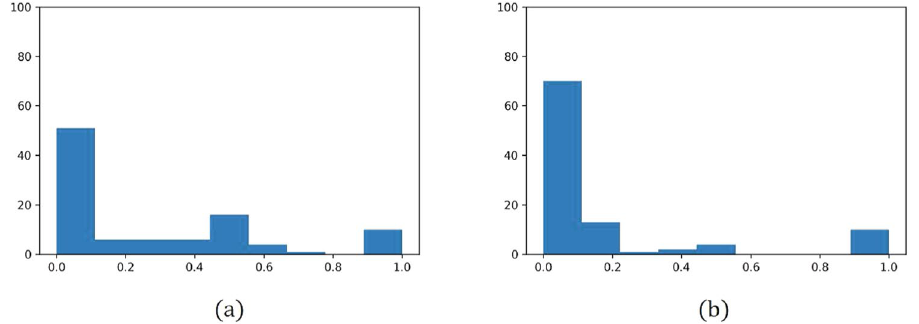
Figure 7. Comparison of the histograms of the total variations of the reconstructed images of Phantom 2 and the variation of the images Phantom 2. The total variations were normalized to [0.0, 1.0] and the histograms were constructed with a bin size of 0.2. ( a ) Histogram of Phantom 2. ( b ) Histogram of the variation of phantom